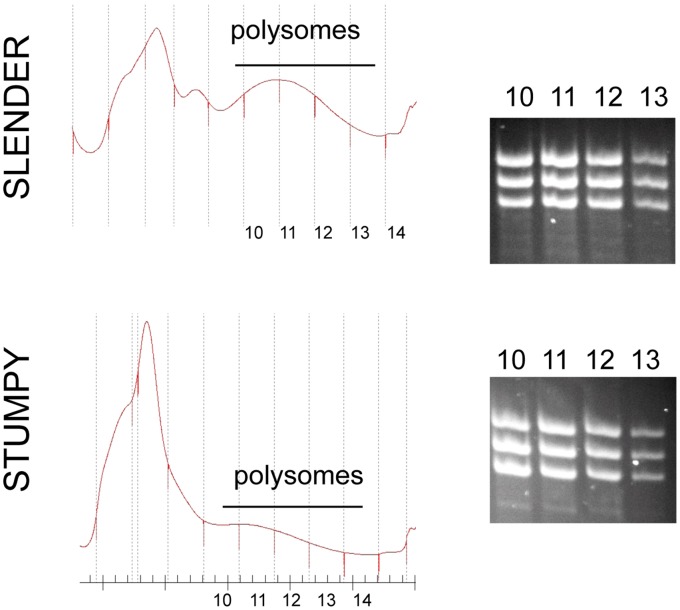
Polysome profiles of slender and stumpy T. brucei AnTat1.1.In each case the derived UV absorbance at 260nm was used to detect the polysomal fractions. Stumpy polysomal material was derived from a pool from 4 mouse infections, with RNA being isolated simultaneously and in parallel. Slender polysome material was isolated from six flasks of 50ml culture. RNA was prepared from fractions 10–13 and these were used to assay transcript levels via digital SAGE. RNA prepared from the polysome enriched fractions are shown to the right hand side in each case. These were pooled for Digital SAGE expression analysis.